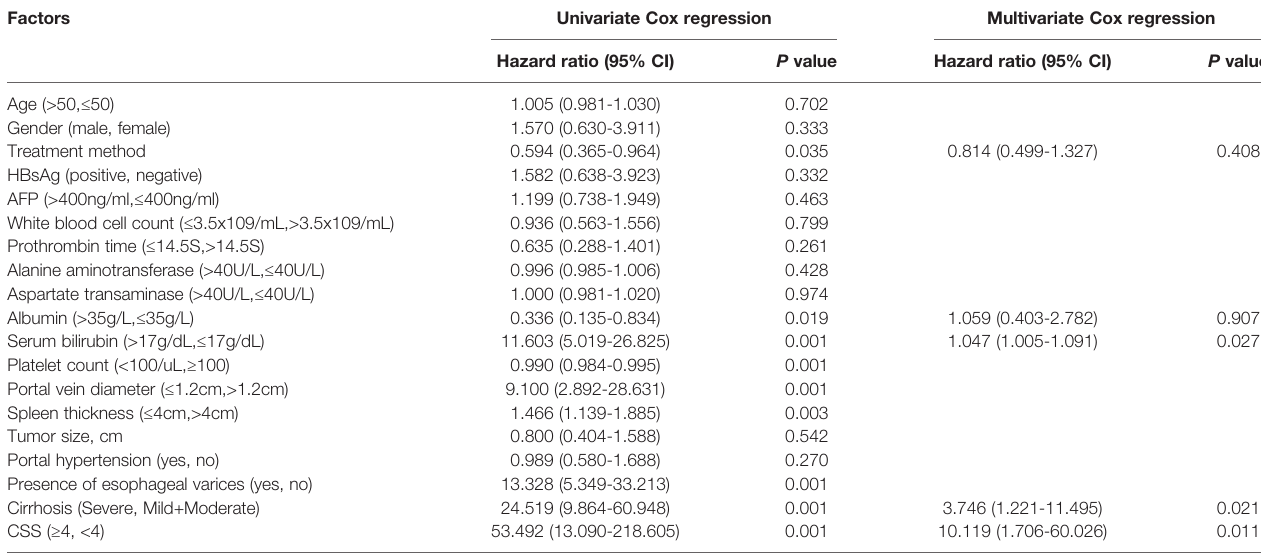
TABLE 4 | Univariate analysis of prognostic factors of overall survival rate. Factors